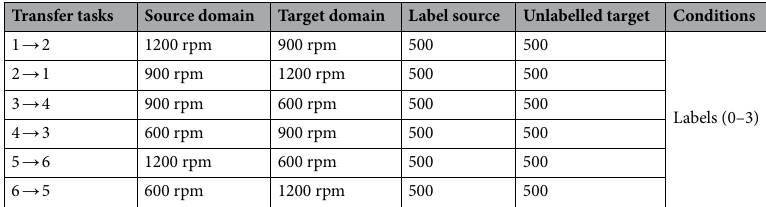
Table 8. Designed transfer tasks for the experiments.